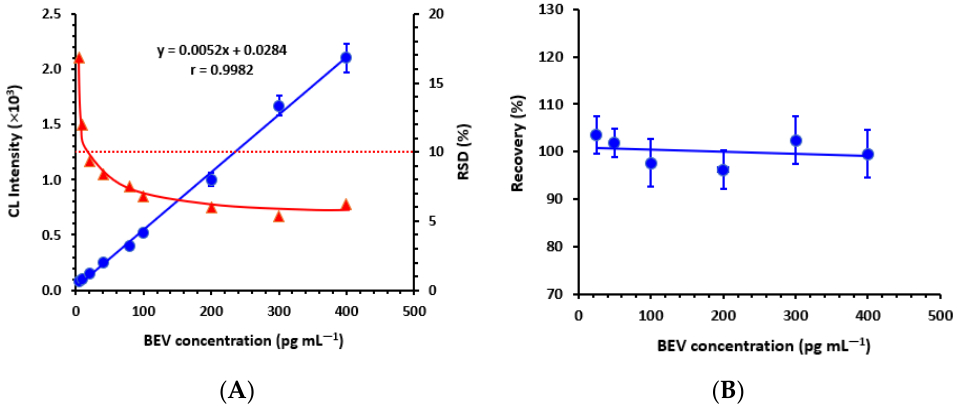
Figure 5. Panel ( A ) calibration curve ( • ) and precision profile ( (cid:78) ) of the proposed CLEIA for BEV. The linear fitting equation of CL intensity (left Y -axis) vs. BEV concentration ( X -axis) and its correlation coefficient (r) are given on the graph. Panel ( B ) recovery study for analysis of diluted plasma samples containing varying concentrations of BEV by the proposed CLEIA. The presented values are mean of 3 determinations ± SD.